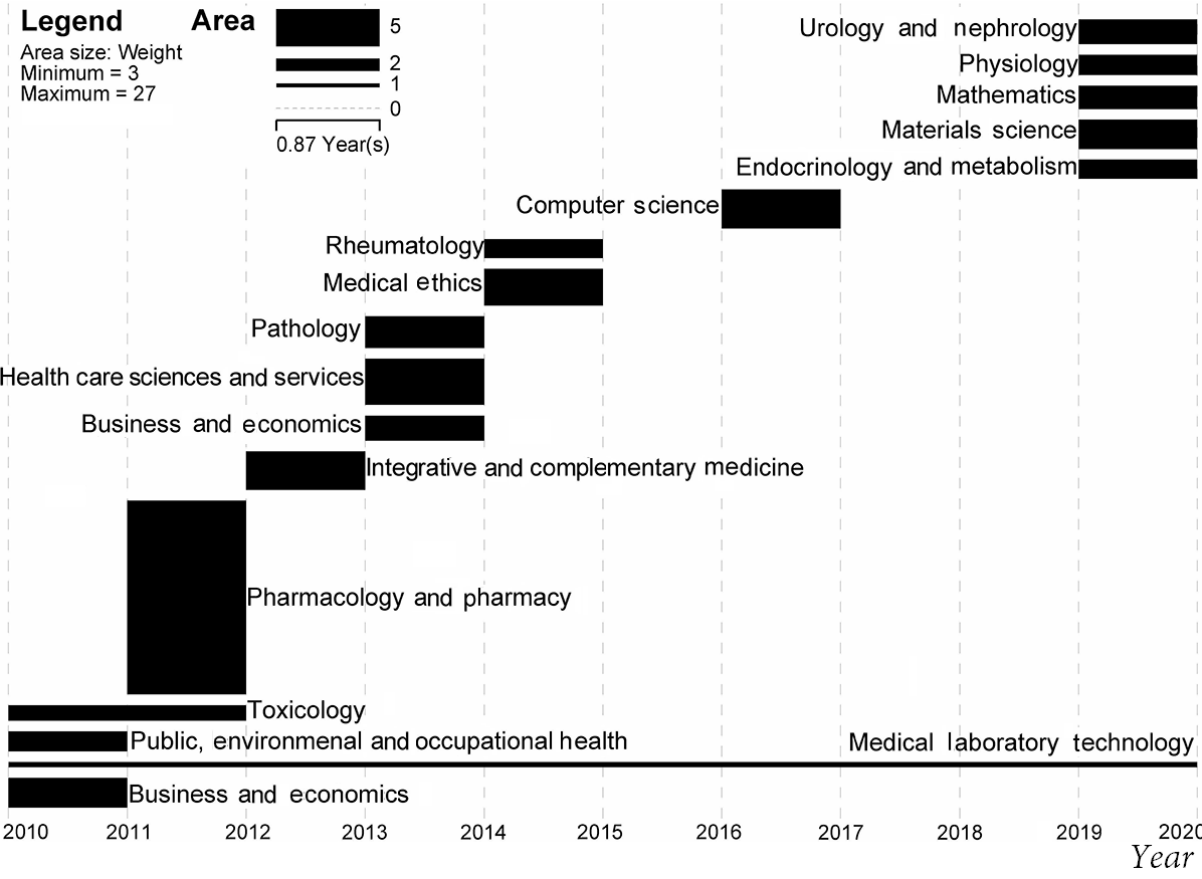
Figure 3. Burst disciplines of precision medicine research from 2010 to